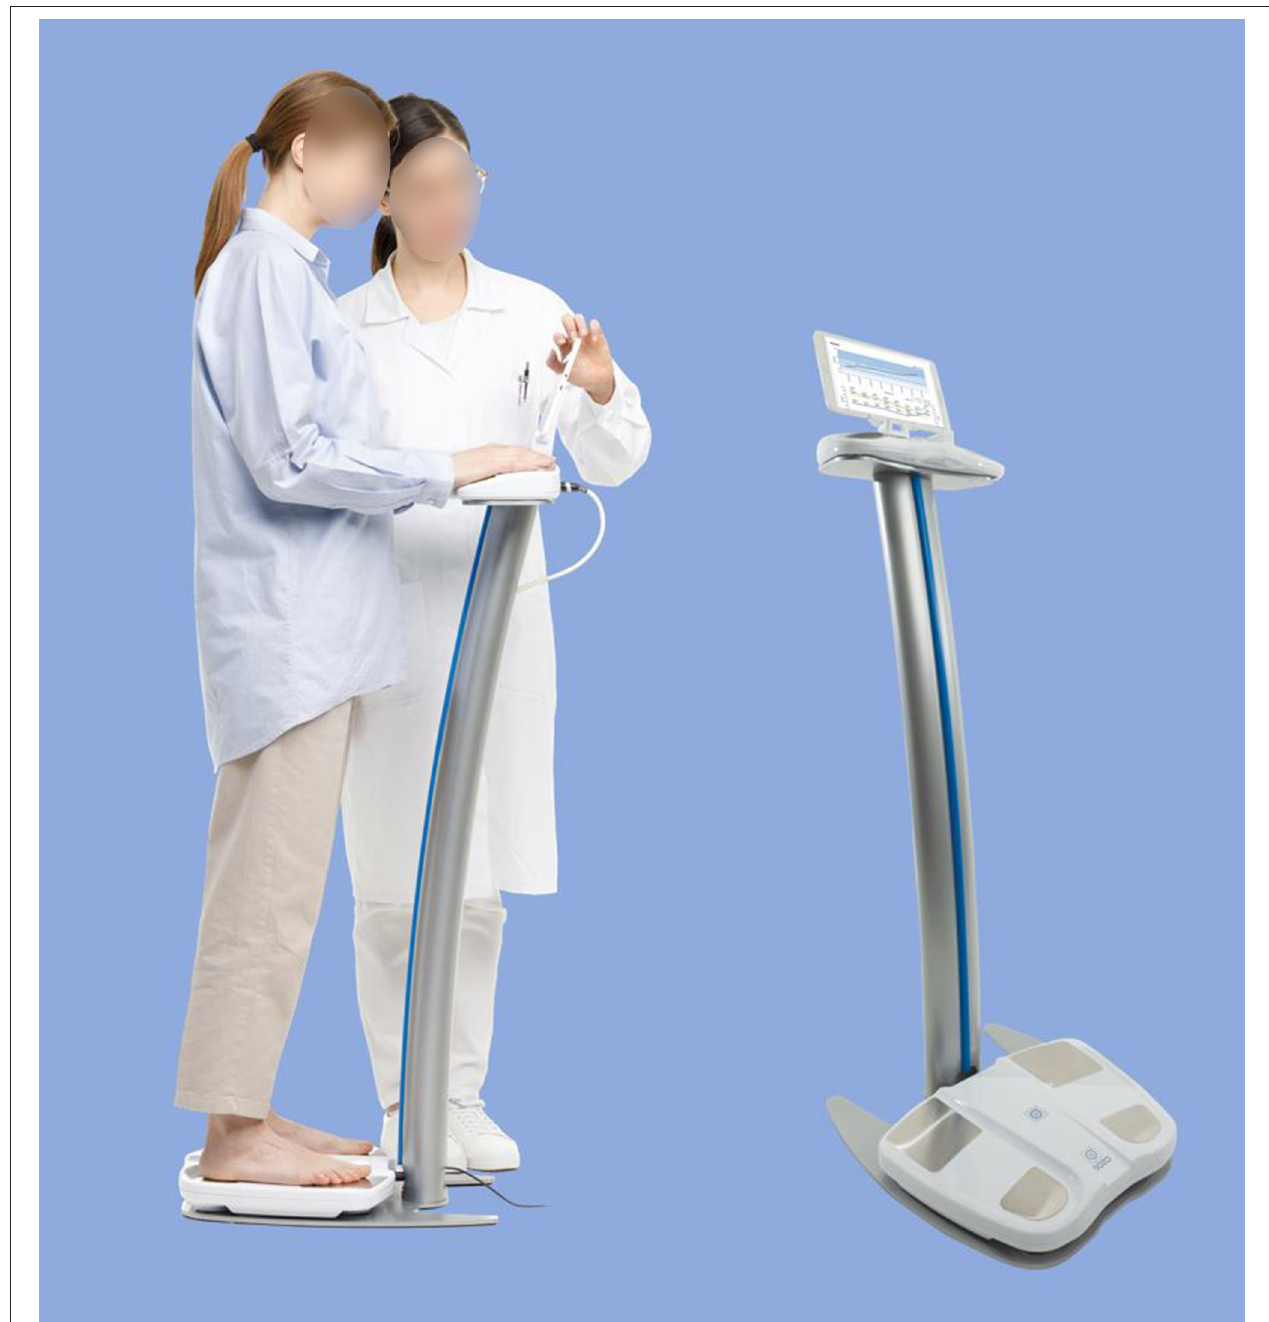
FIGURE 1 | SOZO device. As shown, the device is configured to perform bioimpedance spectroscopy (BIS) measurements with the subject in a standing position. Bare hands and feet must be in direct contact with the electrodes (i.e., no shoes, socks, stockings, or gloves), and metallic/electronic items should be removed. BIS measurement and fluid status reporting takes ∼